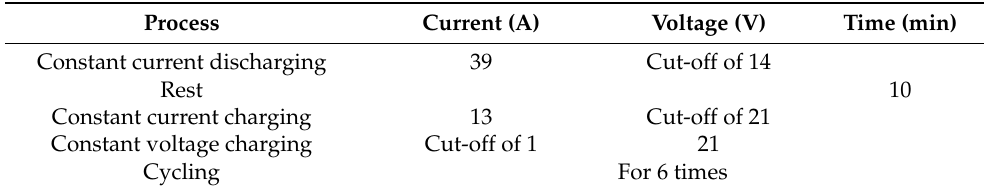
Table 7. Process of cycling